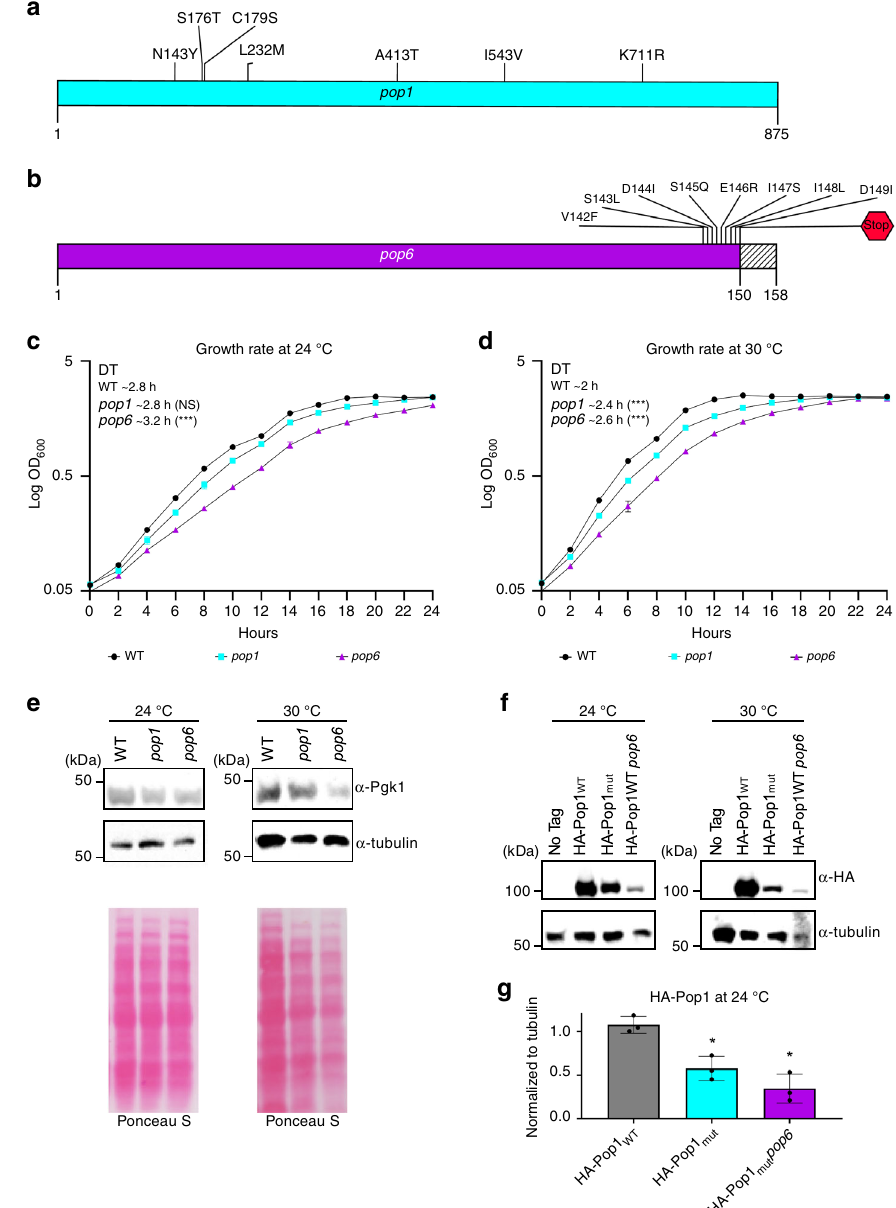
Fig. 2 Growth and global protein levels are similar in pop and WT cells at 24 °C. Diagrams of the proteins encoded by the pop alleles used herein. Silent mutations are not shown. a The positions of the seven amino acid substitutions in the 875 amino acid protein encoded by the pop1 allele (blue) are shown. The nucleotide mutations that led to these substitutions are: 225 G → A, 427 A → T, 526 T → A, 535 T → A, 695 A → T, 792 T → C, 1237 G → A, 1627 A → G, 2132 A → G (numbers are positions of altered nucleotides). b Diagram of the protein produced by the pop6 allele (purple), which contains a deletion at nucleotide 421 resulting in an eight amino acid substitution (amino acids 142 – 149) and loss of the nine terminal aminoacids (dashed lines from 150 – 158) due to a stop codon at position 150. Growth rates of pop1 and pop6 cells at c 24 °C and d 30 °C. e Pgk1 and tubulin proteins from WT, pop1 or pop6 cells grown for ~50 generations were analyzed by western blotting. Although in this western, there appears to be more Pgk1 in WT than in pop cells at 24 °C, using a two-tailed Student ’ s t -test, the differences were not signi fi cant. Total protein was stained with Ponceau S. f Western blots of proteins from a no tag control strain or WT or pop6 cells expressing HA-Pop1 WT or cells expressing HA-Pop1 mut . g Quanti fi cation of HA-Pop1 levels from biological triplicates (black circles) of WT (gray bar), pop1 (blue bar) and pop6 (purple bar) grown at 24 °C were normalized to tubulin and WT protein levels. (Because, epitope tagged mutant Pop6 did not support viability, the effects of temperature on Pop6 were not studied). Error bars are one standard deviation from the average value of three or more independent experiments. P -values were calculated using unpaired two-tailed Student ’ s t -test; * P ≤ 0.05 , **P ≤ 0.01, *** P ≤ 0.001, **** P ≤ 0.0001; NS, not signi fi cant, P >0.05. Source data are provided as a Source Data fi pop6 allele had a single nucleotide deletion near the end of the To establish the appropriate conditions for experiments, we open reading frame. This deletion changed the sequence of 8 determined the growth rates of pop mutants at different amino acids, as well as introducing a stop codon that resulted in a temperatures. At 24 °C, pop1 and pop6 cells had doubling times similar to that of WT in both liquid and solid media (Fig. 2c; nine amino acid truncation (Fig. 2b).